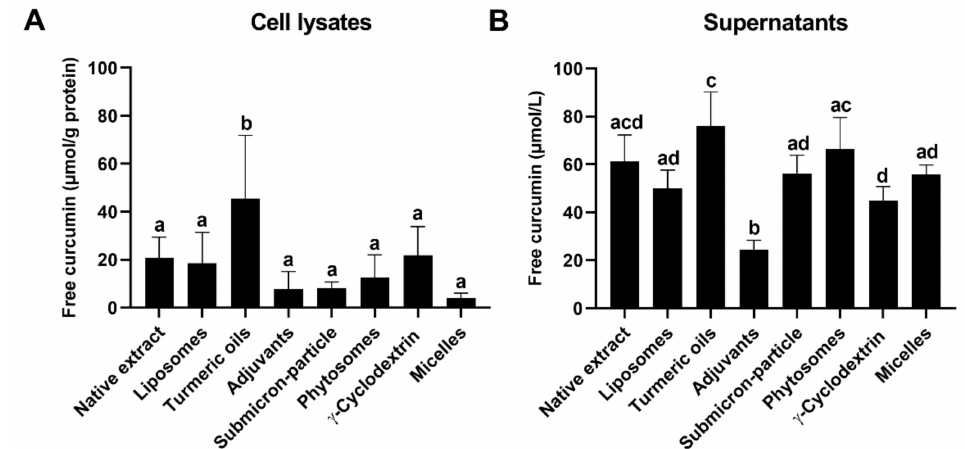
Figure 2. Free curcumin concentrations in ( A ) cell lysates in µ mol/g protein and ( B ) supernatants in µ mol/L after incubation of LS180 cells, with all formulations normalized to 60 µ mol/L curcumin for 1 h at 37 ◦ C and 5% CO 2 . All data are presented as mean ± SD. All experiments were conducted in biological triplicates ( n = 3) and technical duplicates. Bars not sharing a common letter differ significantly at p < 0.05, consequently bars with at least one common letter do not differ significantly at p < 0.05 (one-way ANOVA with Tukey’s post-hoc test).